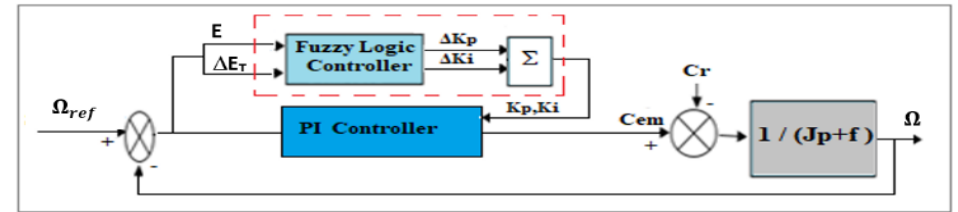
Figure 12. PI controller optimized by fuzzy logic for yellow block in Figure 10.